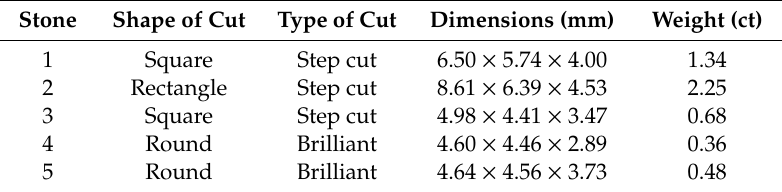
Table 1. Description of the five studied apatite cut stones. Stone Shape of